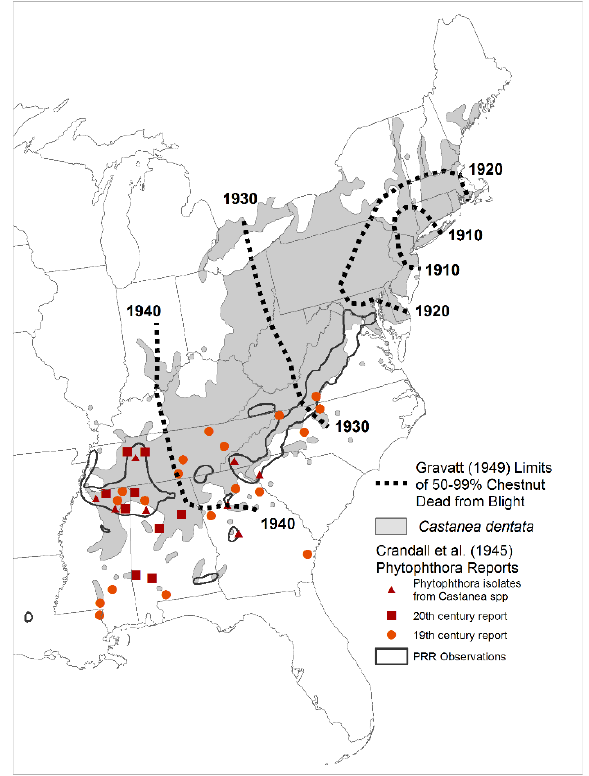
Figure 1. Pre-blight geographic range of Castanea dentata (Little 1977). Dotted lines indicate approximate blight progression (trees dead from blight) from Gravatt (1949). Phytophthora root rot